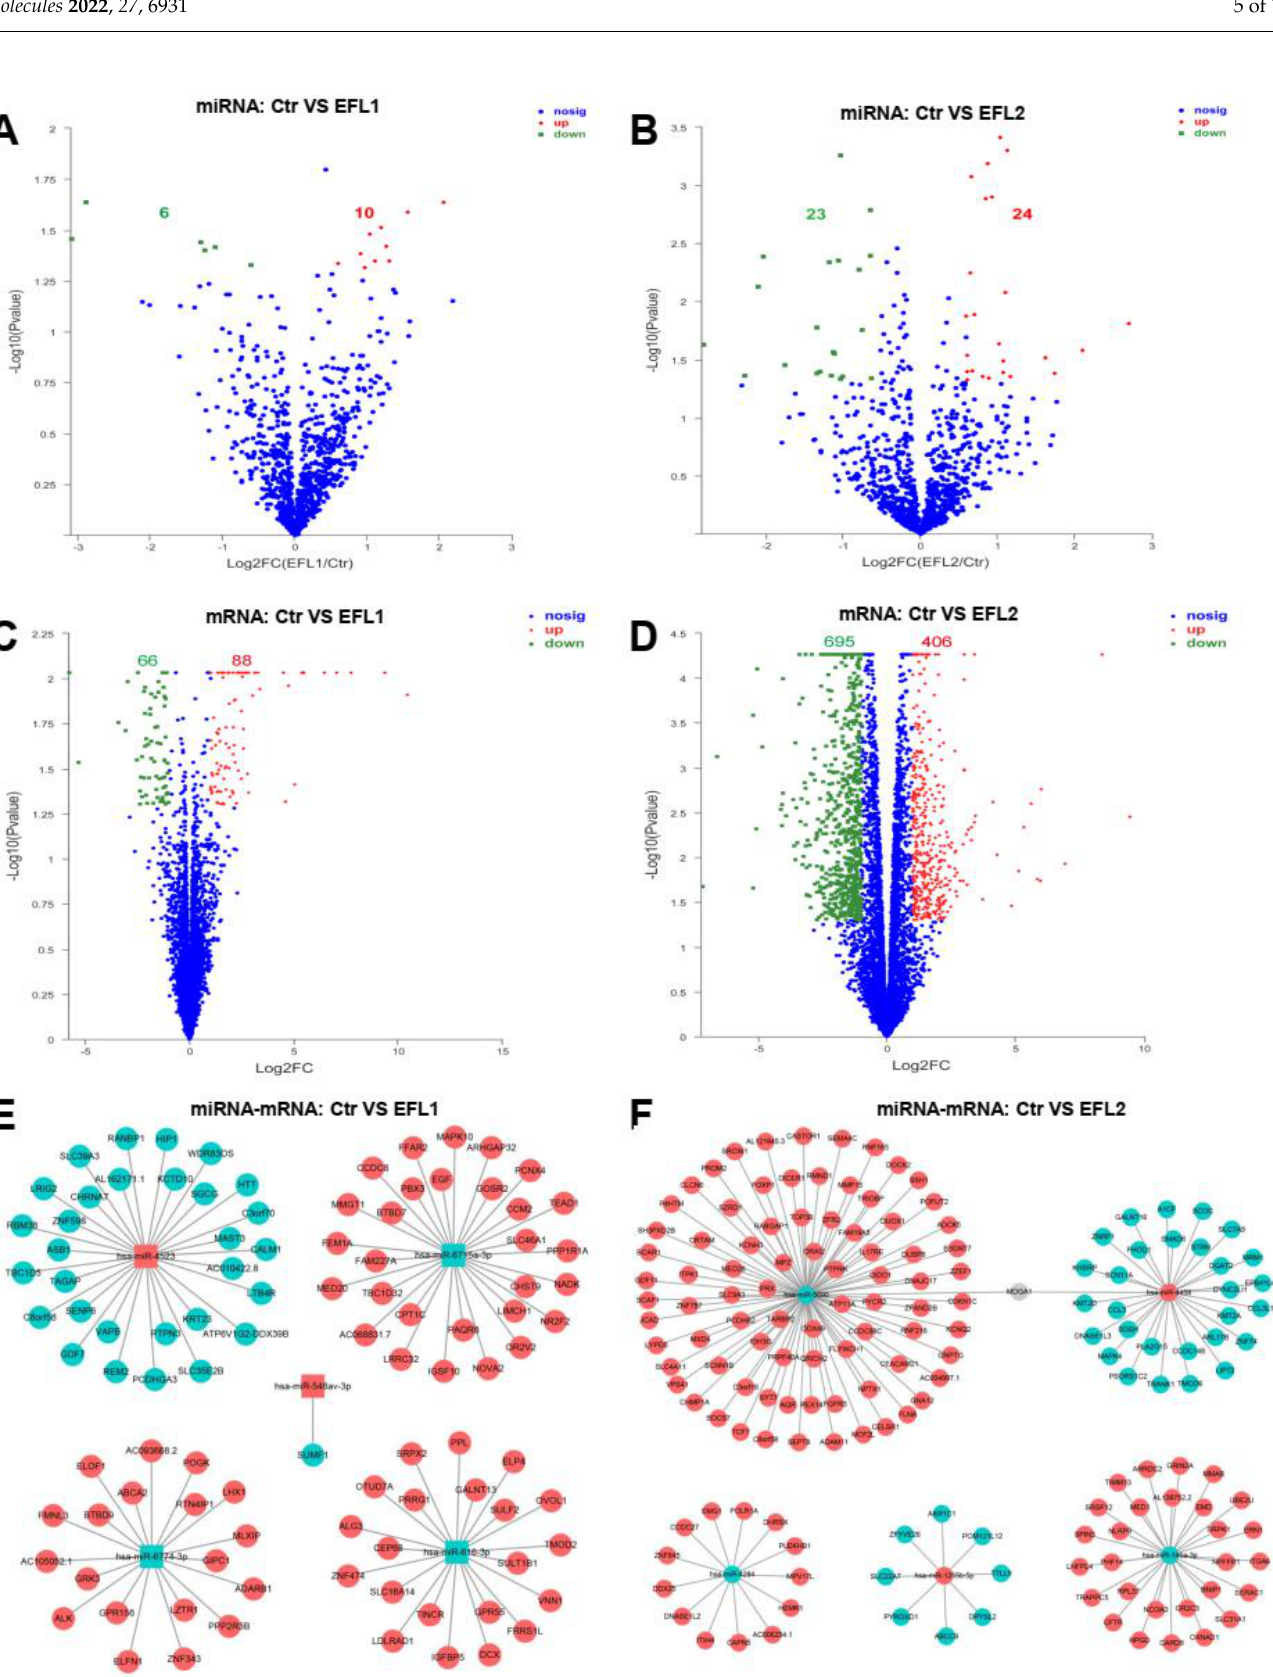
Figure 2. The volcano map of differentially expressed mRNA and miRNA between control and EFLs ( A – D ). The crosstalk between top 5 differentially expressed miRNA and corresponding regulated mRNA ( E , F ). The square is miRNA, and the circle is mRNA. Red is upregulation, and green is down- regulation.